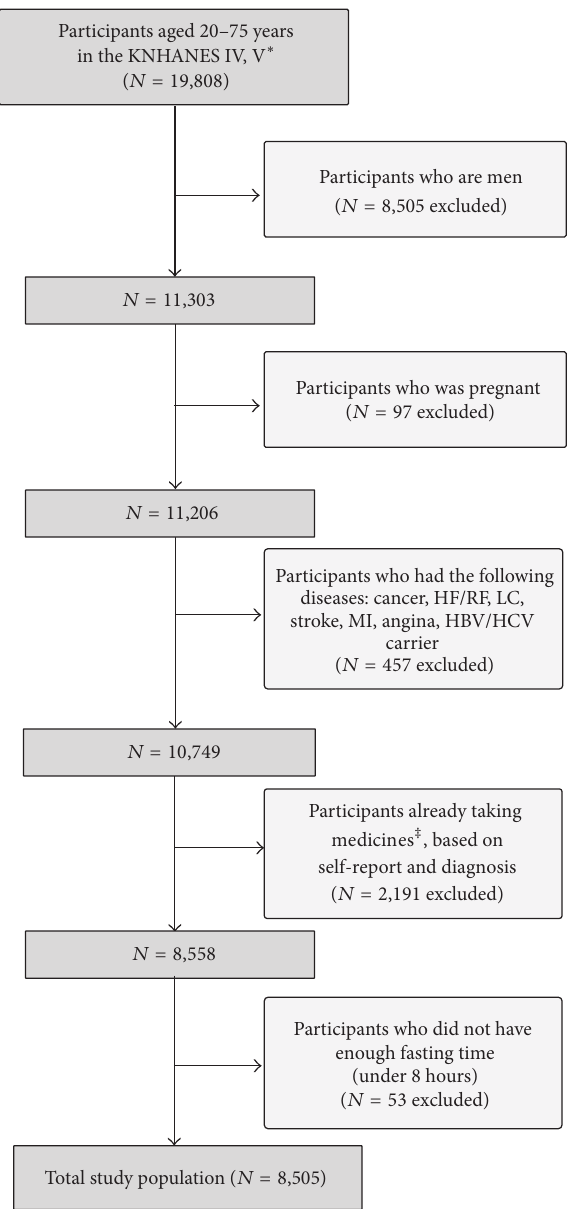
Figure 1: Participants flowchart. ∗ The Fourth and Fifth Korean National Health and Nutrition Examination Surveys. † Ordinary activities including working, studying, chores, or leisure activities. ‡ Medicines for antihypertensive, antihyperlipidemia, antihyper- glycemic effect. HF: hepatic failure; RF: renal failure; LC: liver cirrhosis; CRF: chronic renal failure; MI: myocardial infarction; HBV: hepatitis B virus; HCV: hepatitis C